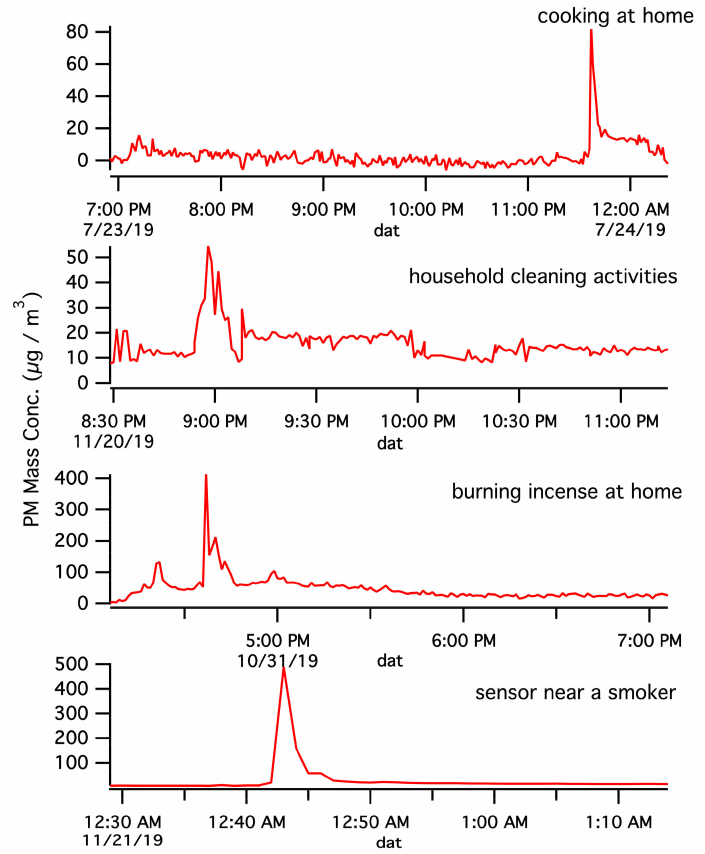
Figure 6. Sample monitoring results for end users during the trial implementation. Real-time personal exposure monitoring allows improved understanding of the times, locations, and extent of high exposure events. The sensors were in the same room adjacent to the end user during the